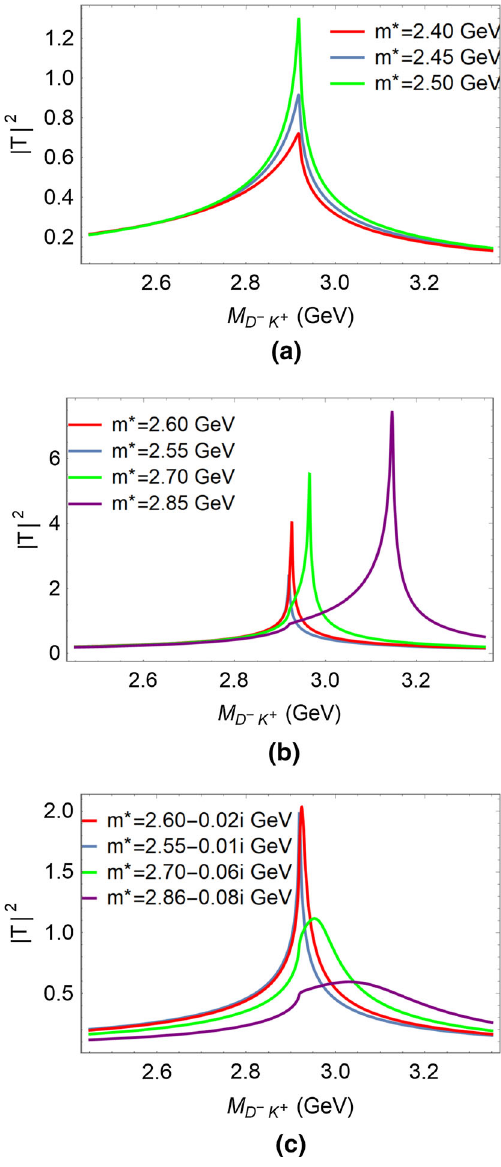
Fig. 7 Lineshapeoftrianglediagramswithdifferent m ∗ : a s 12 − located in the upper half-plane of sheet II; b s 12 − located in the lower half-plane of sheet II and m ∗ has no width; c s 12 − located in the lower half-plane of sheet II and m ∗ has a finite